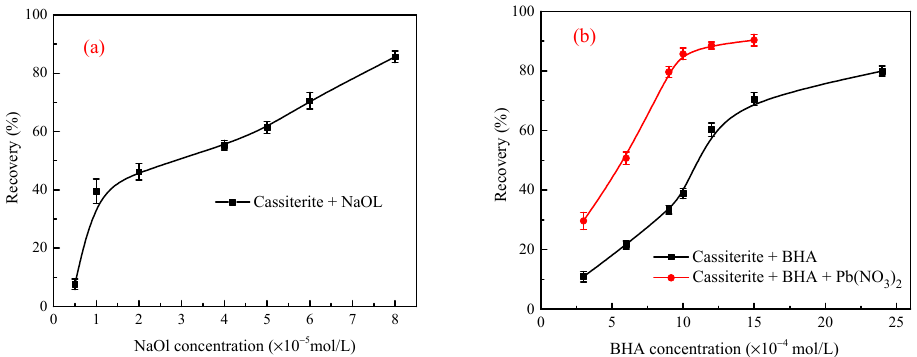
Figure 2. Effect of NaOL ( a ) and BHA ( b ) concentrations on the flotation recovery of − 37 + 10 µ m cassiterite (pH = 8.5).